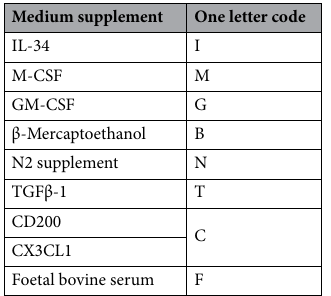
Table 2. The single letter code used for different microglial medium components in this